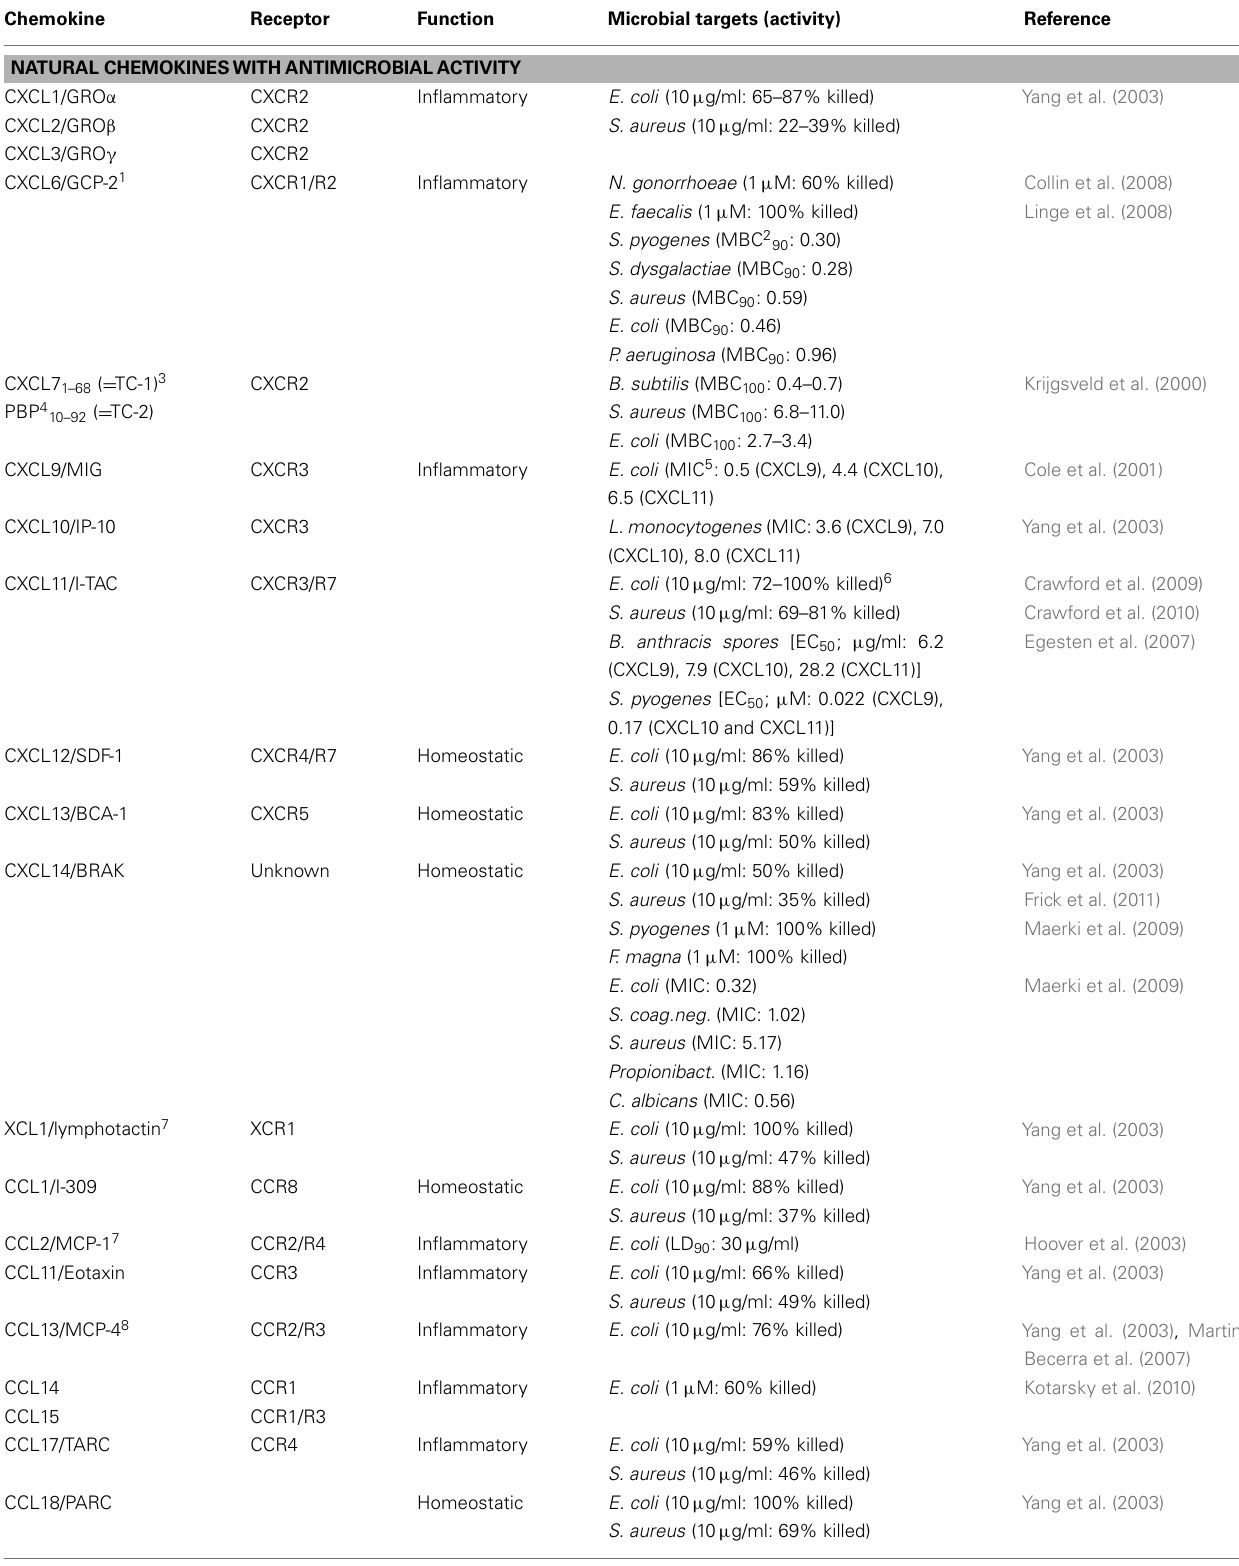
Table 1 |Antimicrobial activities of